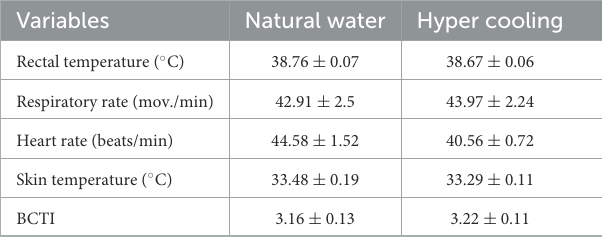
TABLE 3 Means and standard deviation of physiological variables and adaptability index of horses submitted to two cooling methods, in Ananindeua, Pará.